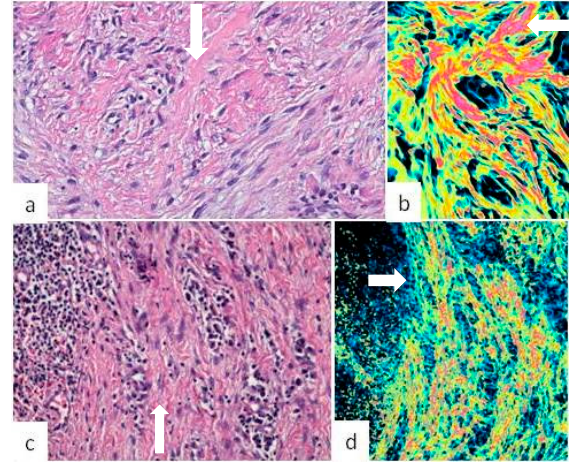
Figure 4. Histological analysis of the samples obtained from patients of experimental group D ( a , b ) highlights the presence of mature connective tissue, with low vascular density, abundant old collagen without inflammatory cells ( a ) (arrow), as confirmed by the high fluorescence seen by Confocal Laser Scanning Microscopy ( b ) (arrow). In opposition, the histological analysis of the surgical specimens obtained from patients of the control group D shows the presence of young connective tissue ( c ) (arrow), with abundant inflammatory infiltrate, high vascular density, immature collagen and fibroblast characterized by round nuclei, as confirmed by the low auto-fluorescence observable via the Confocal Laser Scanning Microscope ( d ) (arrow).